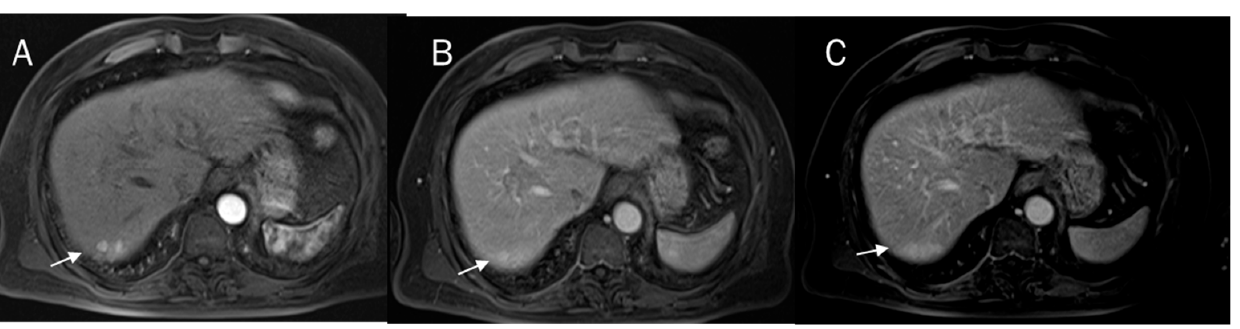
Figure 2. Satellite nodules (arrows) on VII hepatic segment with progressive contrast enhancement during the arterial ( A ), portal ( B ), and late ( C ) phases of contrast study.